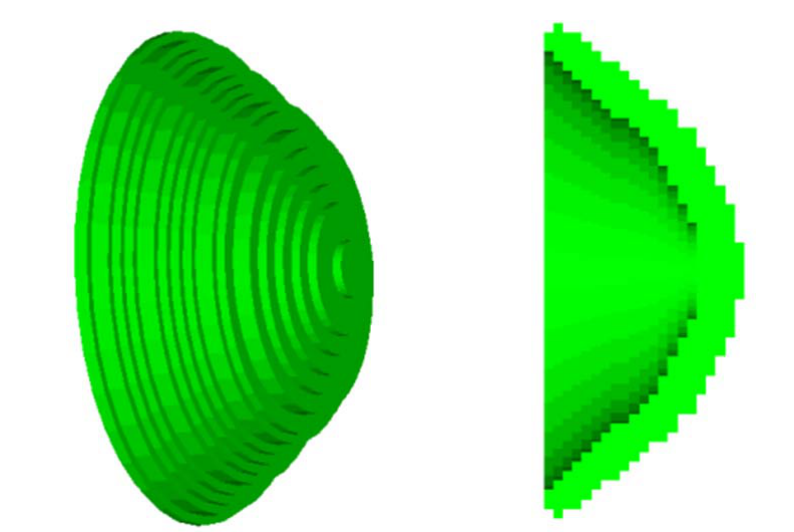
Figure 24. Fully formed copper penetrator, after 160 µs (Autodyn)